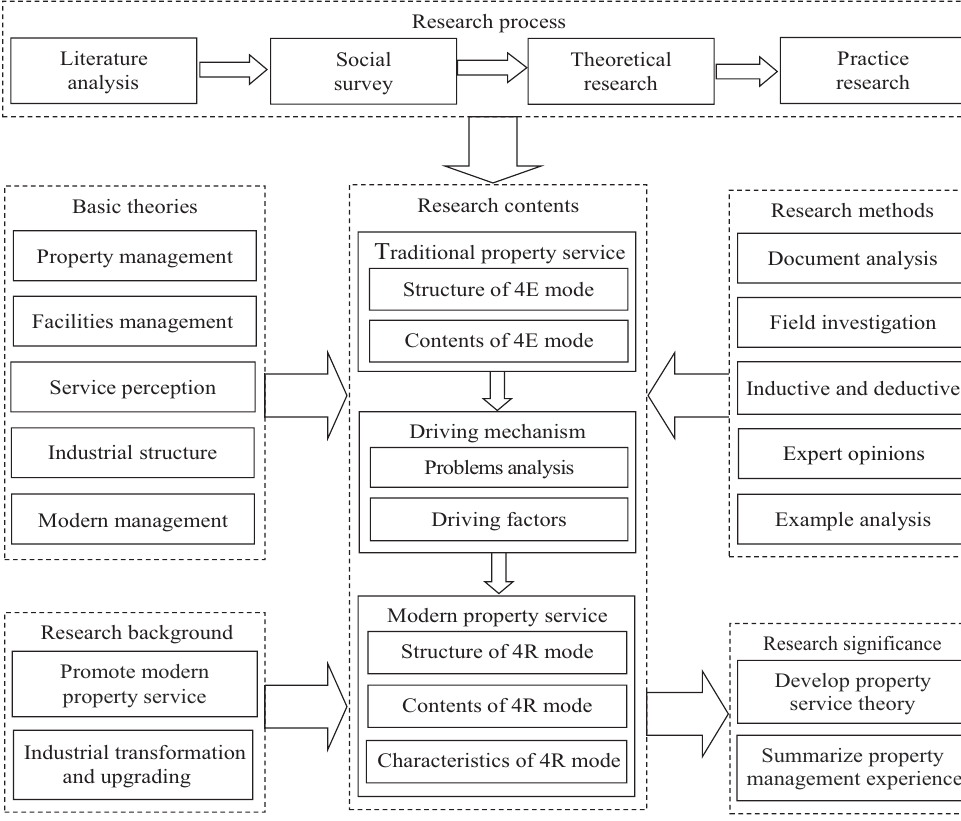
Figure 1. Research framework